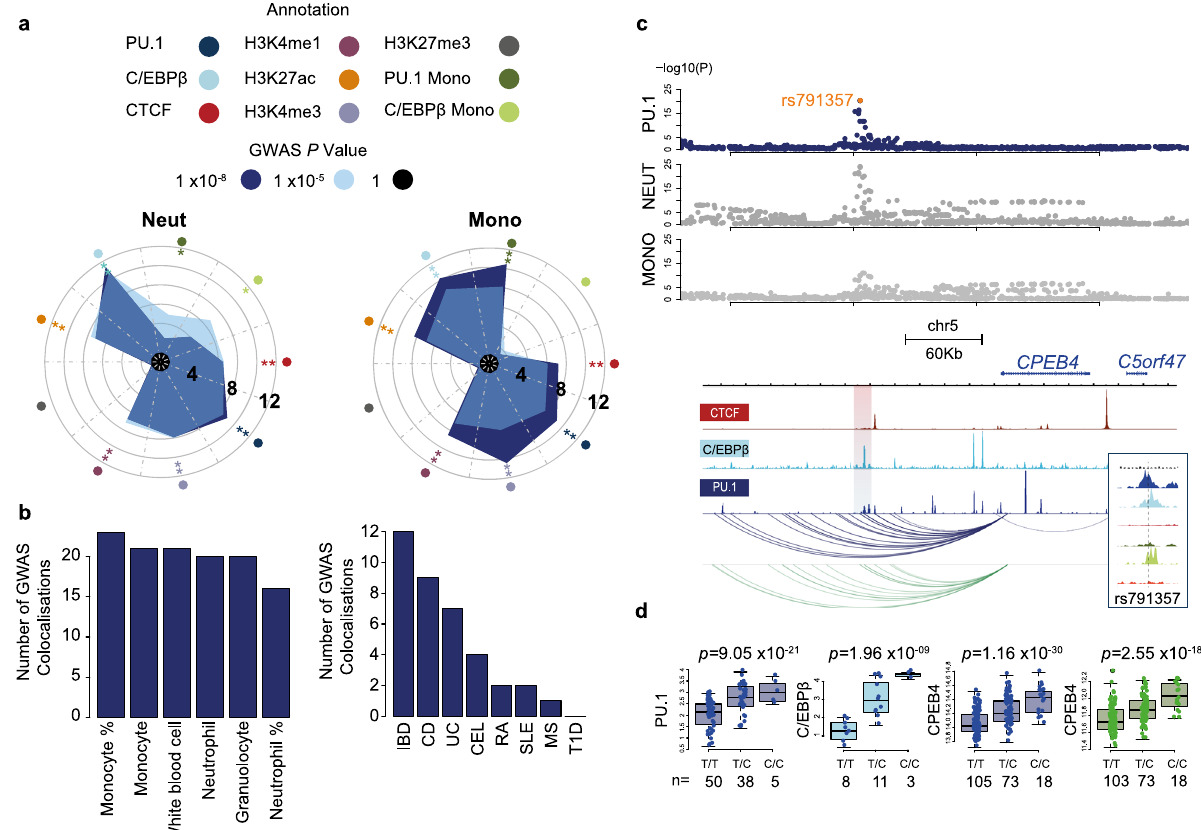
Fig. 5 tfQTLs in fl uence cellular phenotype and disease. a Circos plots displaying fold-enrichment of GWAS loci for neutrophil count and monocyte count within neutrophil regions marked by TF binding, modi fi ed histones and PU.1 and C/EBP β speci fi c binding sites in monocytes. Radial grid lines for published GWAS p values, asterisk denotes signi fi cance of enrichment for annotation tested at each GWAS p value cut off. b Bar plot displaying the number of GWAS loci that colocalise with PU.1 tfQTL for both full blood count phenotypes (left) and autoimmune disease (right). c Example of colocalised signal for sentinel SNP rs791357 tfQTL with a shared association for both neutrophil and monocyte count traits. Manhattan plots showing − log10( P ) value for shared SNPs from published GWAS for neutrophil and monocyte counts obtained by fi tting linear models, and PU.1 tfQTL (navy) obtained from LIMIX. With genome browser visualisation of locus for CTCF, C/EBP β and PU.1 binding shown beneath. The top associated peak is highlighted by the shaded area. In addition, PCHi-C data show that this region is highly connected to the enhancer region in both neutrophils (blue) and monocytes (green). d Boxplot for TF and RNA signal segregated by donor genotype. PU.1 (navy), CEBP β (light blue), CPEB4 gene expression neutrophil (navy) and CPEB4 gene expression monocyte (olive green). Box plots show the medians (centre lines) and the twenty- fi fth and seventy- fi fth percentiles (box edges), with whiskers extending to 1.5 times the interquartile range. p values were obtained by fi tting linear mixed models implemented in LIMIX. n = the number of individual